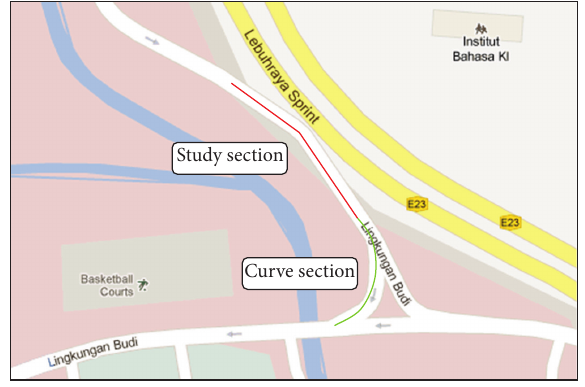
Figure 4: Speed profile and change rate before curve